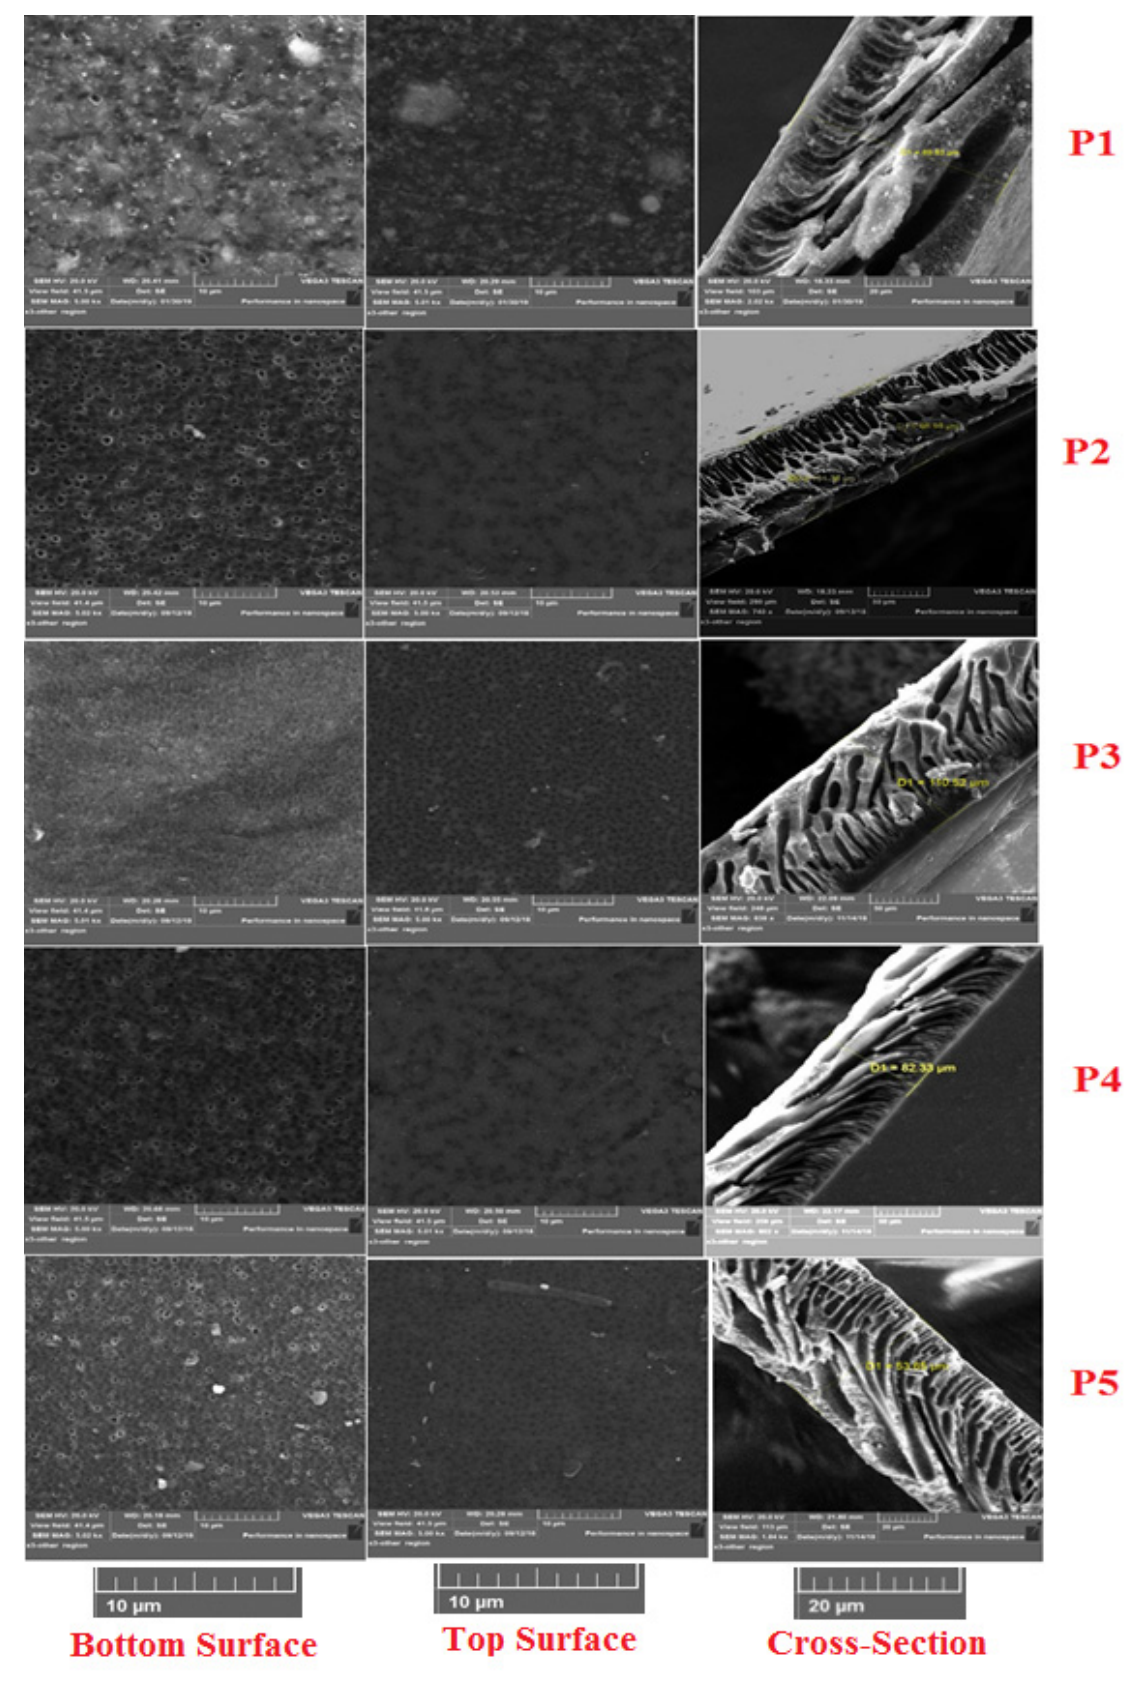
Figure 1. Scanning electron microscopy (SEM) images of PPSU and PPSU-PES membranes at various PES contents.